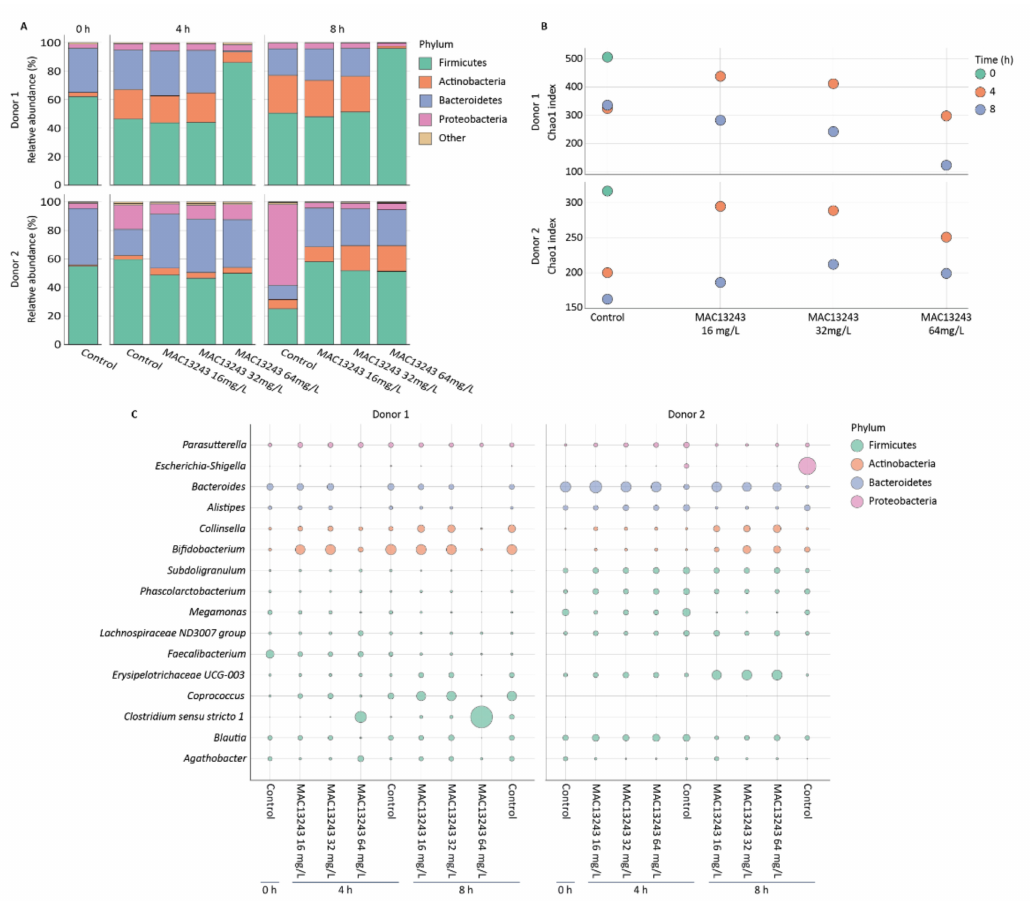
Figure 4. Effects of MAC13243 on microbiota composition and diversity in faecal samples from two human donors; ( A ) relative abundance at the phylum level; ( B ) alpha diversity; ( C ) bubble plots showing the proportion of the highest abundant genera across all